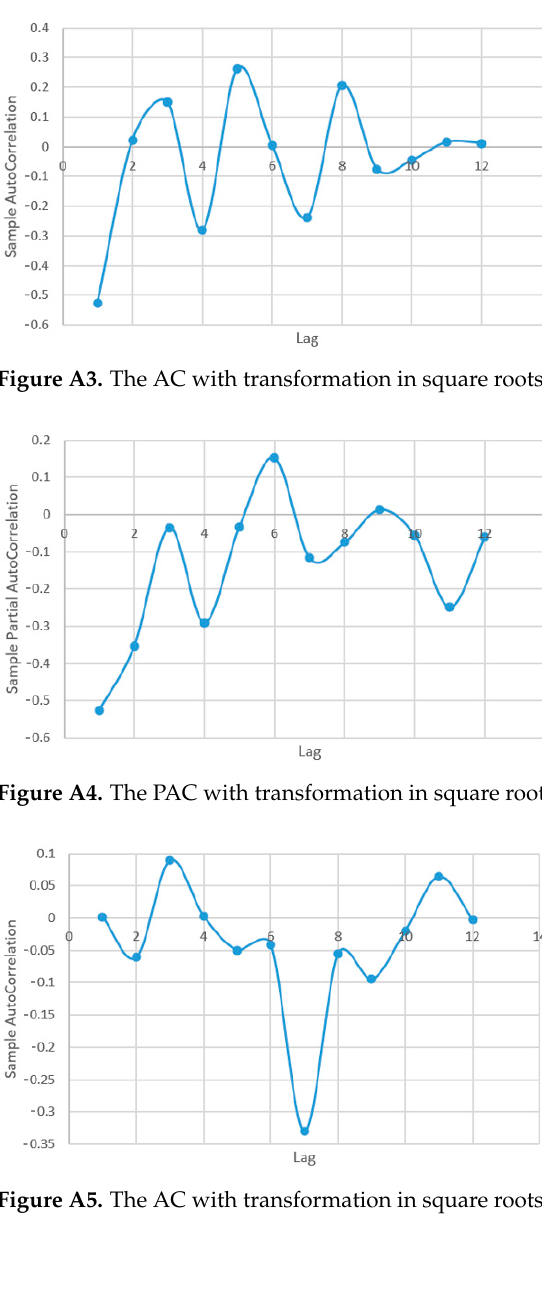
Figure A6. The PAC with transformation in square roots—AH series.